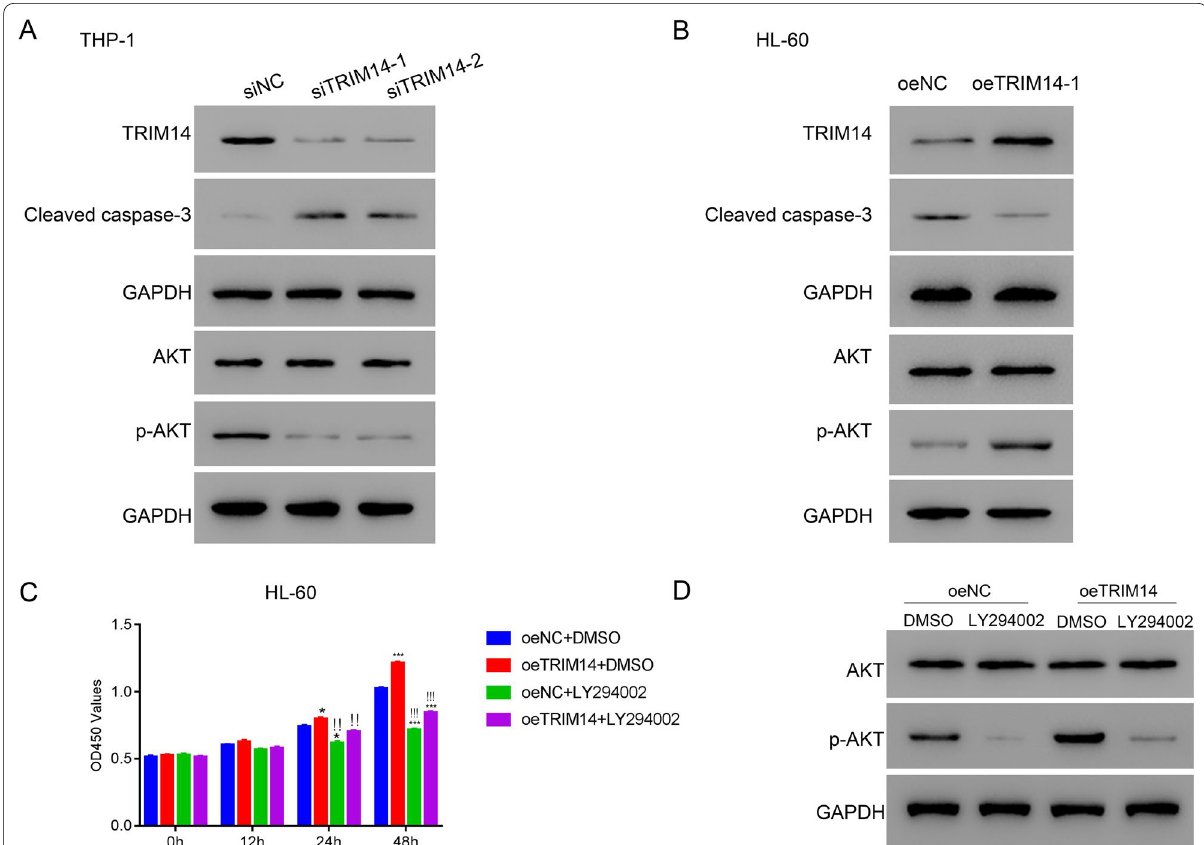
Fig. 2 Inhibition of PI3K/AKT pathway suppressed the function of TRIM14 in AML. A – B The expression of TRIM14, cleaved caspase-3, AKT and p-AKT in AML cells after transfecting with TRIM14 siRNAs ( A ) or overexpressed plasmid ( B ). C The proliferation of HL-60 with the application of oeTRIM14 and LY294002. D The expression of AKT and p-AKT in HL-60 cells with the application of oeTRIM14 and LY294002. * p < 0.05 vs oeNC DMSO, *** + p < 0.001 vs oeNC DMSO; !!*p < 0.05 vs oeTRIM14 DMSO; !!!***p < 0.001 vs oeTRIM14 + + +